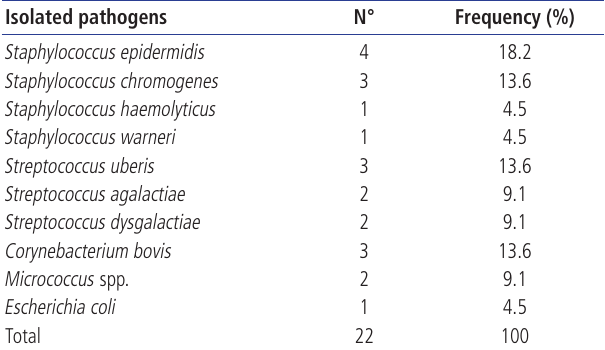
Table 4. Proportion of the 22 isolated microorganisms (genus and species) of milk of 30